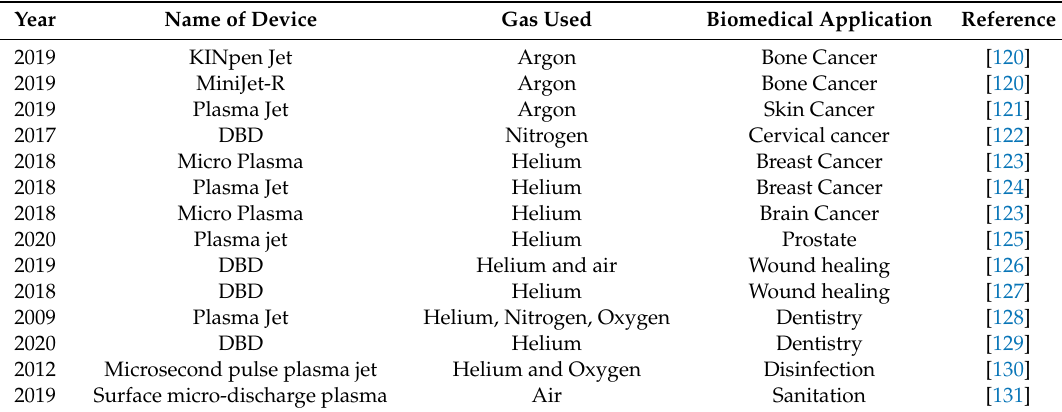
Table 1. Di ff erent types of NTP devices used in biomedical